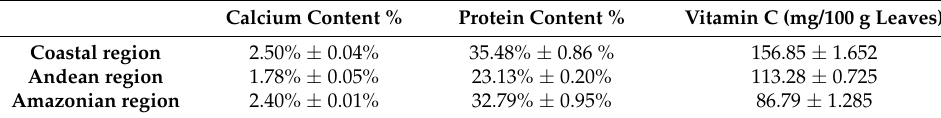
Figure 3. The phytochemical and biological composition of M. oleifera from the Andean region. Loading plot of PC1 versus PC2, showing the link between DPPH with TFC, Fe, and protein. Leg- end: TPC — total phenolic content, TFC — total flavonoid content, FRAP — ferric-reducing antioxi- dant power, ABTS — free radical scavenging activity, DPPH — free radical scavenging ability by the use of a stable DPPH • radical.